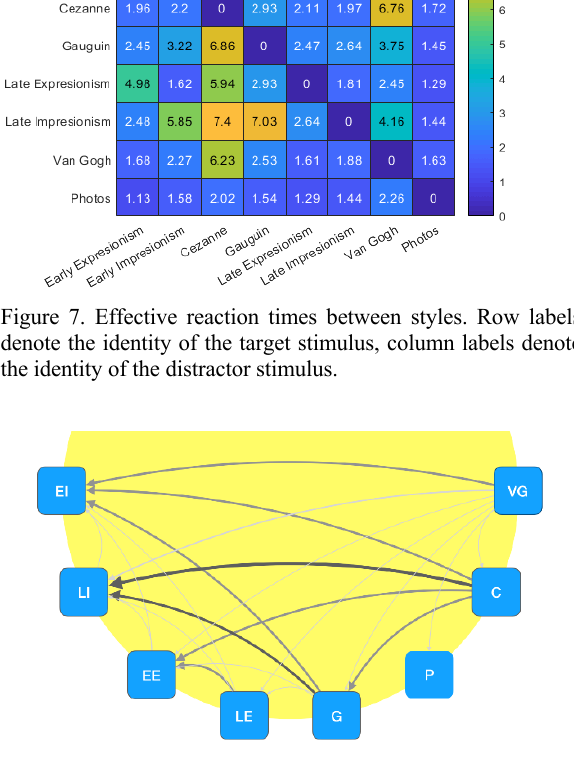
Figure 8. Transitive relationship between styles. The direction of arrows denotes that a strict hierarchical relation exists be- tween styles. The thickness of arrows denotes the difference between a style serving as distractor and as target when com- pared to another style. EI: early Impressionism; LI: late Im- pressionism; EE: early Expressionism; LE: late Expressionism; G: Gauguin; P: Photography; C: Cézanne; VG: van